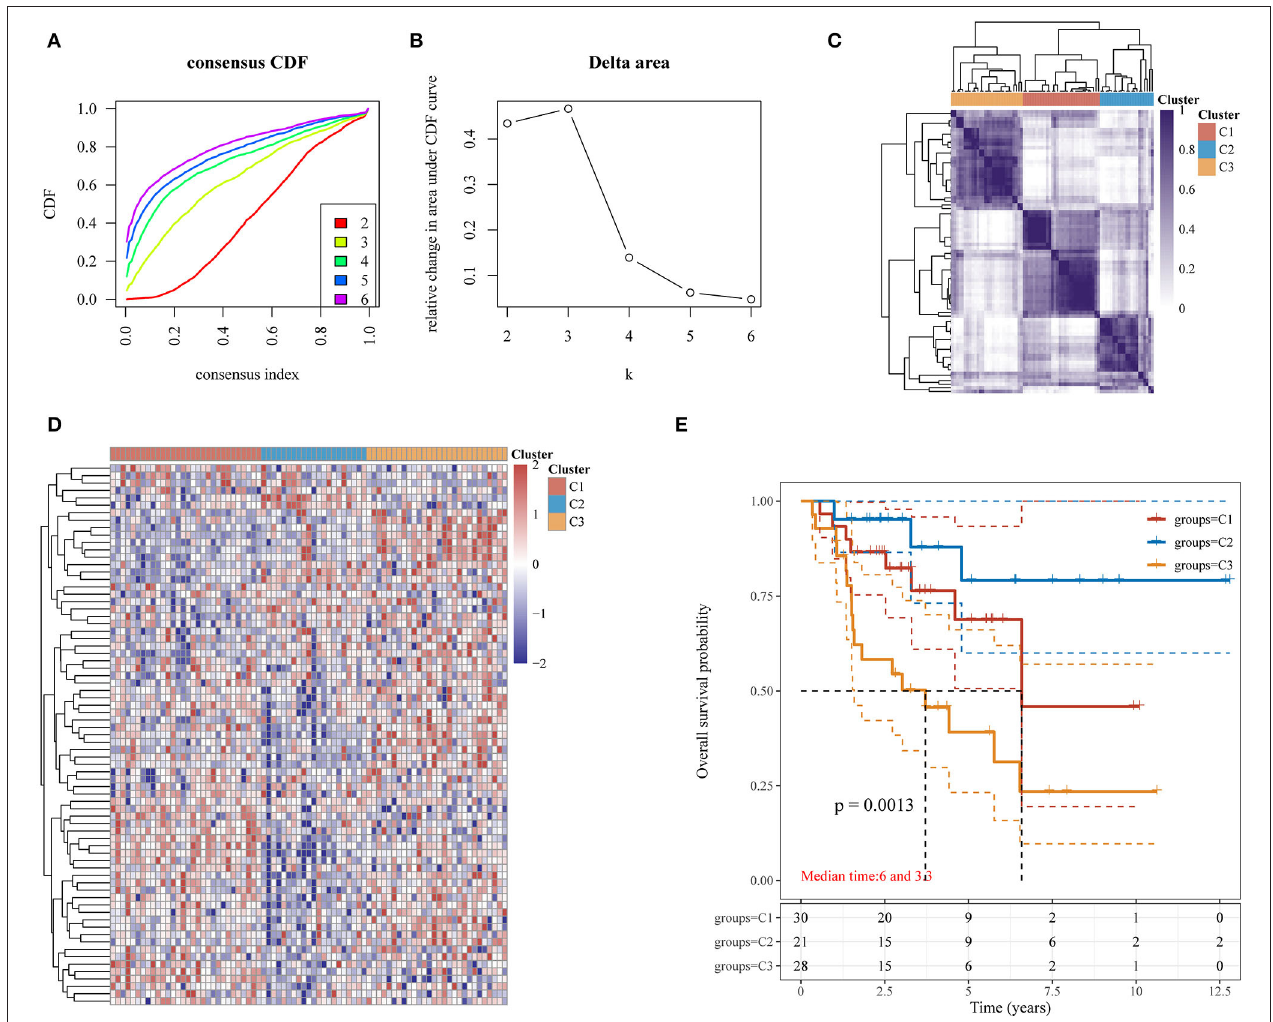
FIGURE 2 | Identification of three molecular subtypes based on hypoxia-related gene expression in ACC. (A) Consensus CDF; (B) Delta area; (C) Heatmap of consensus clustering solution ( k = 3) for hypoxia-related genes in ACC ( n = 79); (D) Heatmap for hypoxia-related gene expression among the three hypoxia-related subtypes; (E) Kaplan-Meier OS curves for patients with ACC among the three hypoxia-related subtypes. ACC, adrenocortical carcinoma; CDF, cumulative distribution function; OS, overall